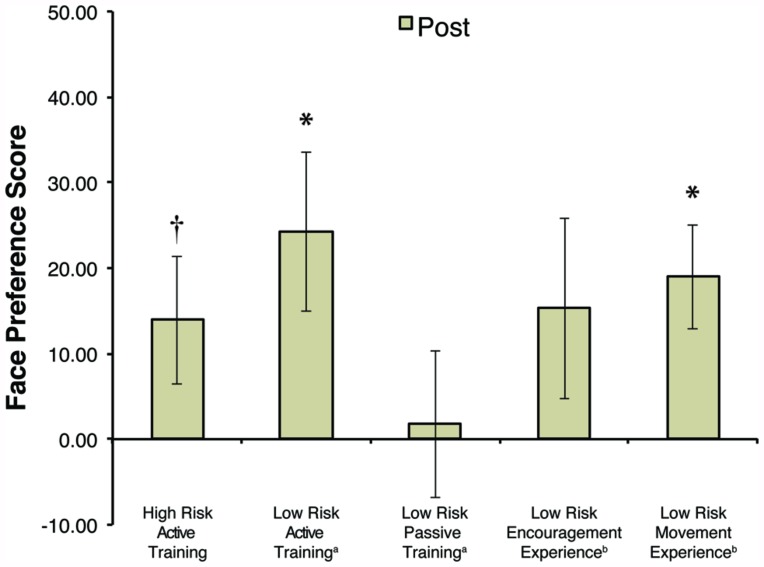
Average face preference scores after training (Post) by group. Data from the LR groups was taken from (a) Libertus and Needham (2011) or (b) Libertus and Needham (2014). Error bars represent SEM, *p < 0.05, †p = 0.086.